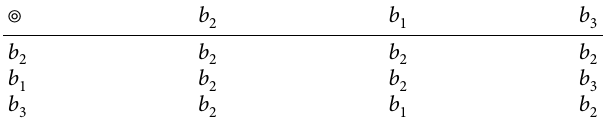
Table 1: Composition of C under the rule ⊚ .